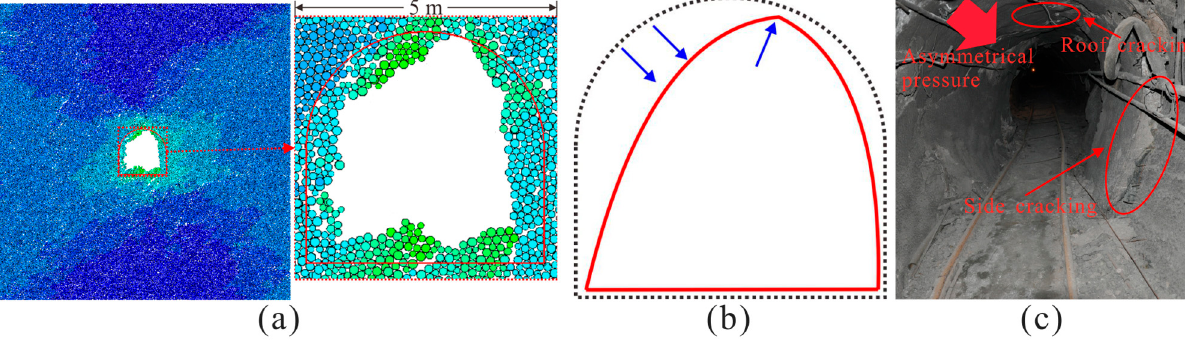
Figure 13. Schematic diagram of peach-shaped failure. ( a ) Numerical simulation result; ( b ) Failure mechanism; ( c ) Field